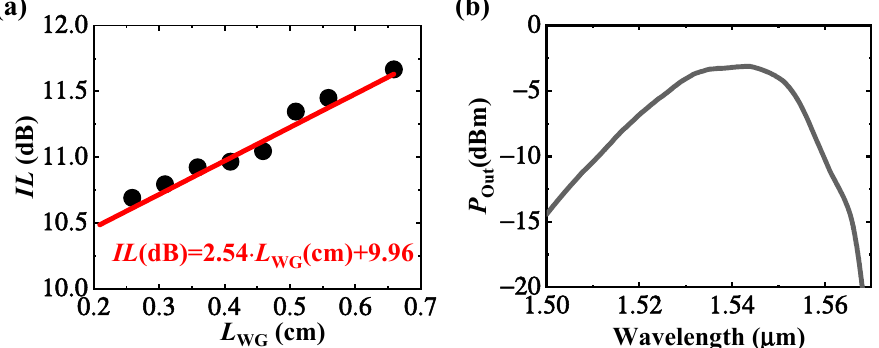
Figure 5. ( a ) Insertion loss of the “grating-waveguide-grating” structure is the function of the waveguide length (the black dot is measured data and the solid red line is the linear fitted result); ( b ) The optical response spectrum of the grating.